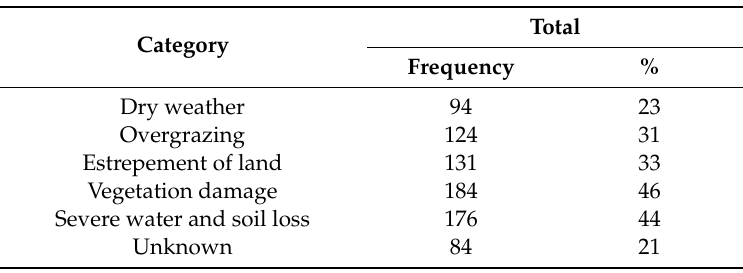
Table 5. Farmers’ awareness regarding the causes of environmental degradation.